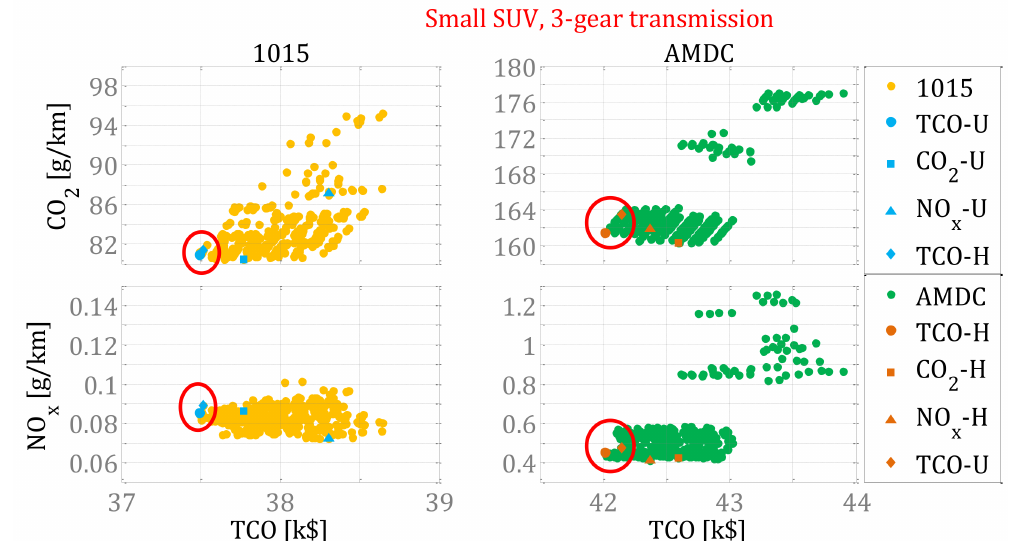
Figure 5. CO 2 ( top ) and NO x emissions ( bottom ) versus TCO of the small SUV 3gTR designs over the 1015 (U, yellow dots) and AMDC (H, green dots) missions.